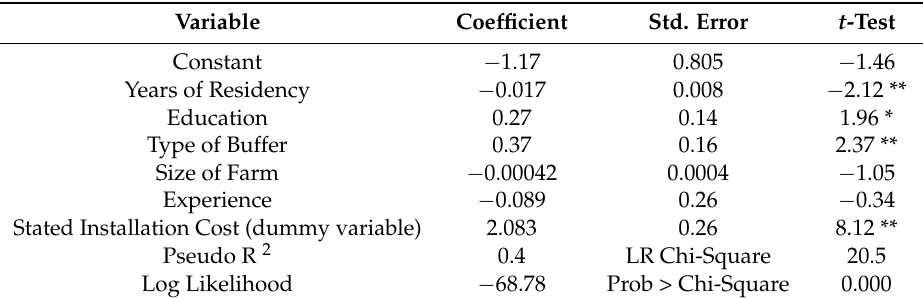
Table 2. The role of offering a monetary payment on participation in the water quality trading program in Jordan Lake, North Carolina. Variable